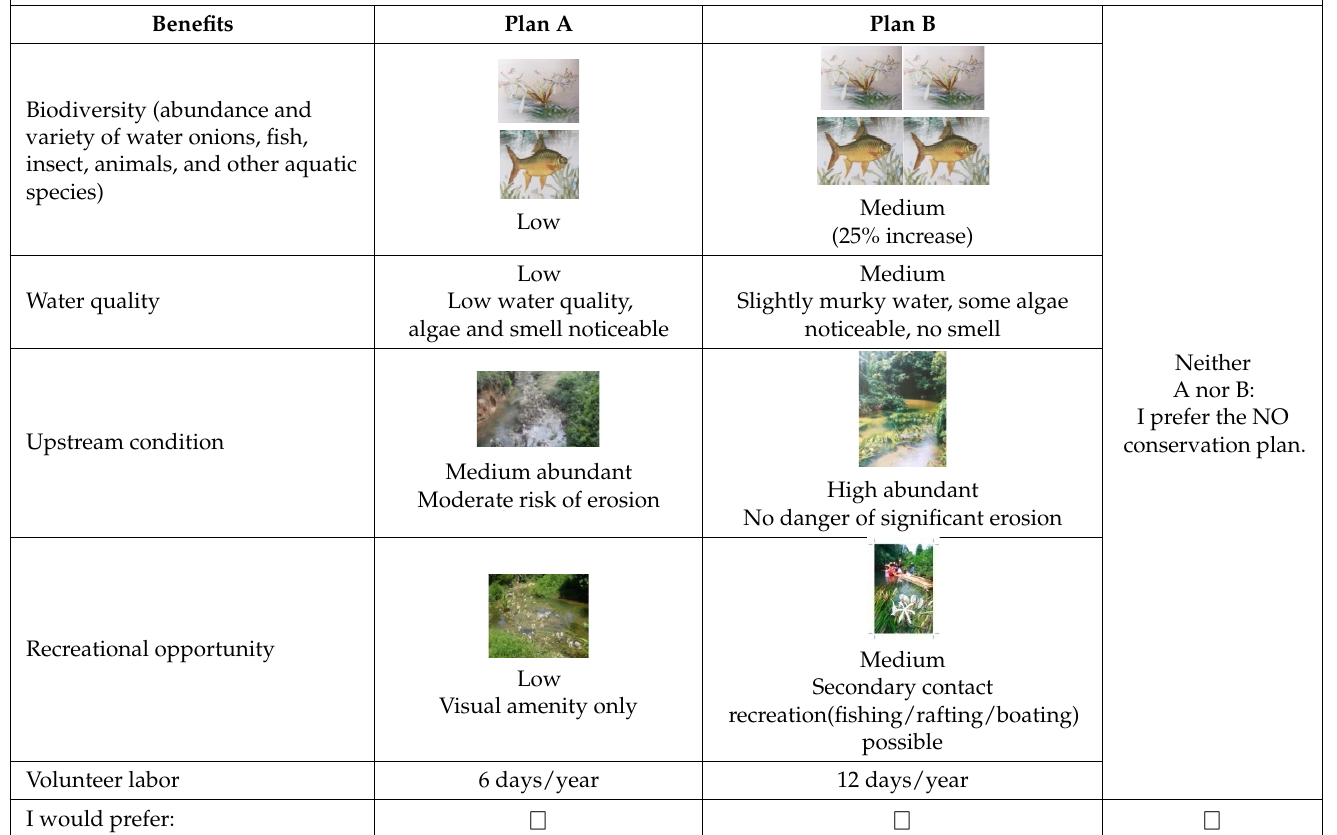
Table 3. Example of a choice set for the CE task in volunteer labor terms.